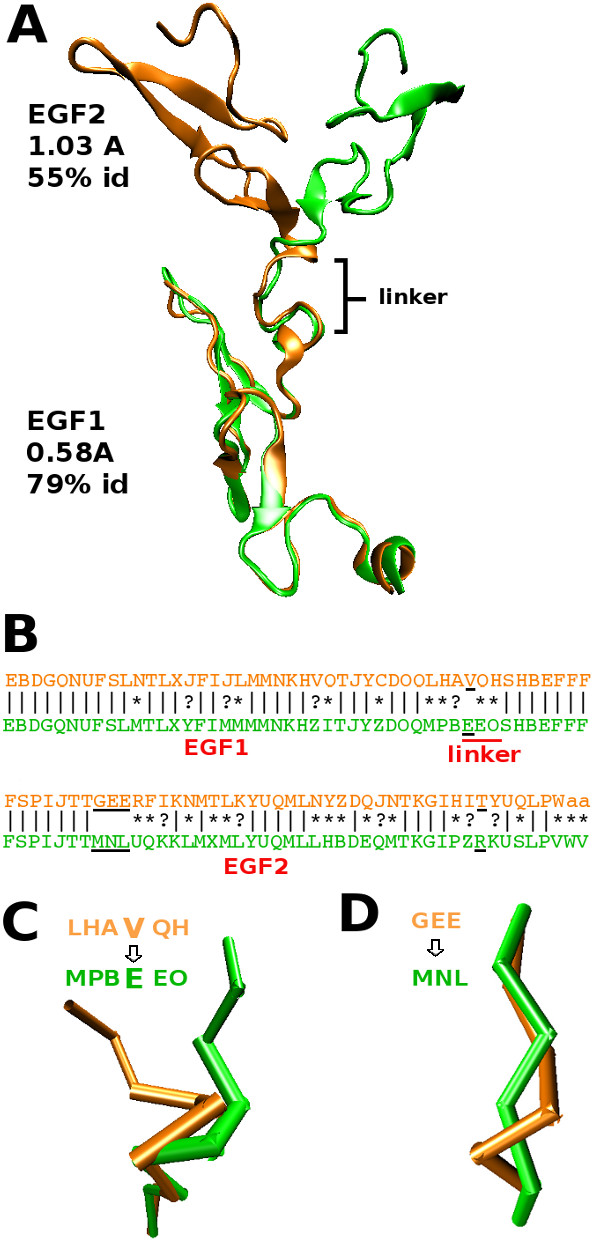
Deformation between regular and non-regular secondary structures. A) The structural superimposition of the EGF1 and EGF2 domains of the light chain of the coagulation factor VIIa in unbound (orange) and bound (green) states. B) The alignment of the structural sequences associated with the bound and unbound states of the protein is presented, | stands for identities, * for transitions between structural letters of the same secondary structure type, ? for transitions involving border-letters. The three deformed regions that do not fit the deformation tendencies are underlined in black. B and D) Zoom on the linker region (B) and region close to linker region (D) that undergo deformations that violate the deformation tendencies, the corresponding structural sequences are shown.